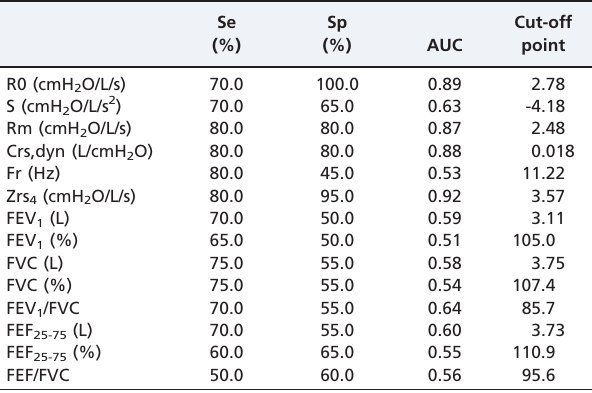
Table 2 - Values of area under the ROC curve (AUC), sensibility (Se), specificity (Sp) and respective cut points for the FOT and spirometric parameters.